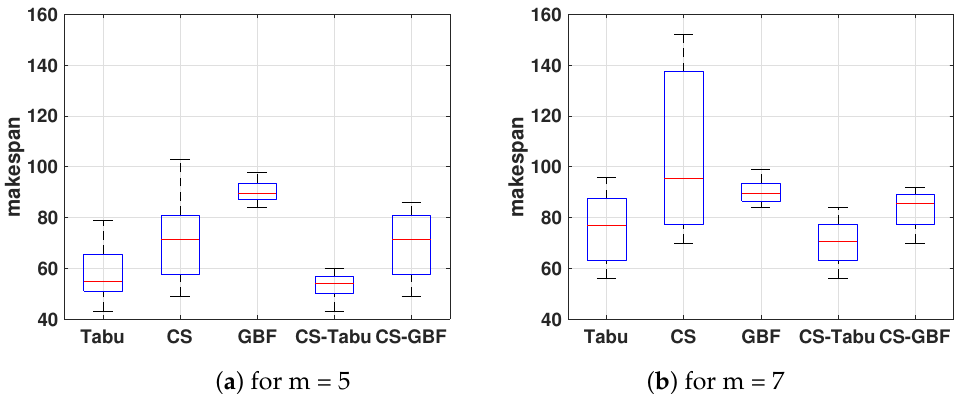
Figure 5. Performance of Tabu search algorithm, crowdsourcing (CS), greedy best-first (GBF) search algorithm, and the merged approaches (CS-Tabu and CS-GBF) for solving the Job Shop Scheduling (JSS) for ( a ) m = 5 and ( b ) m = 7,